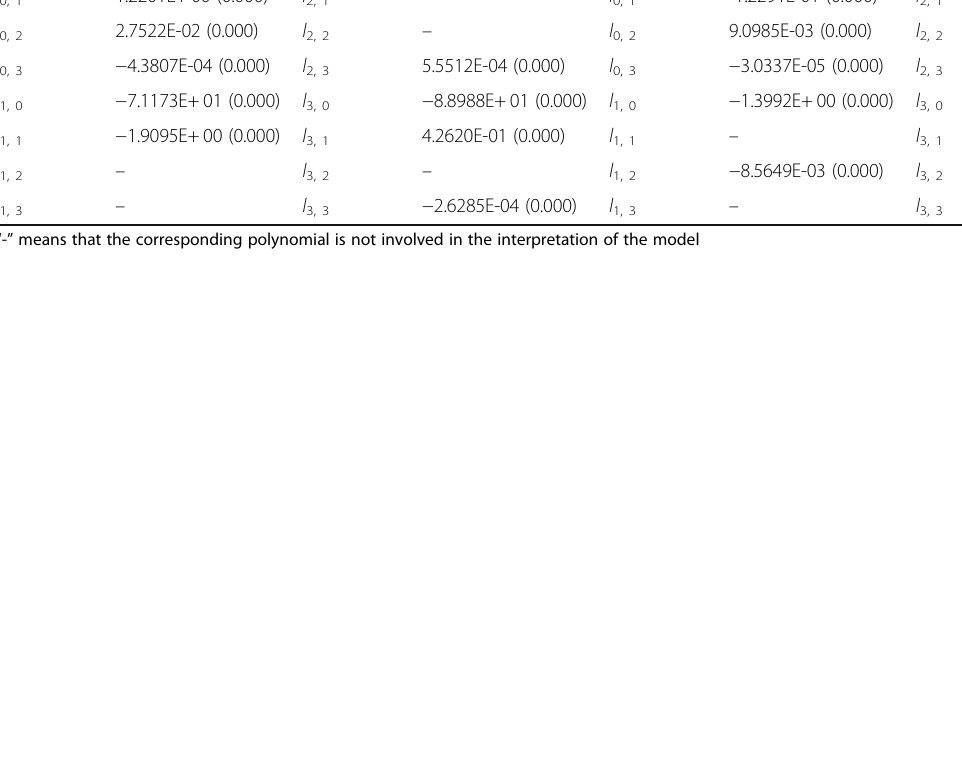
Table 7 Regression coefficient of the statistical model considering road section speed Fuel